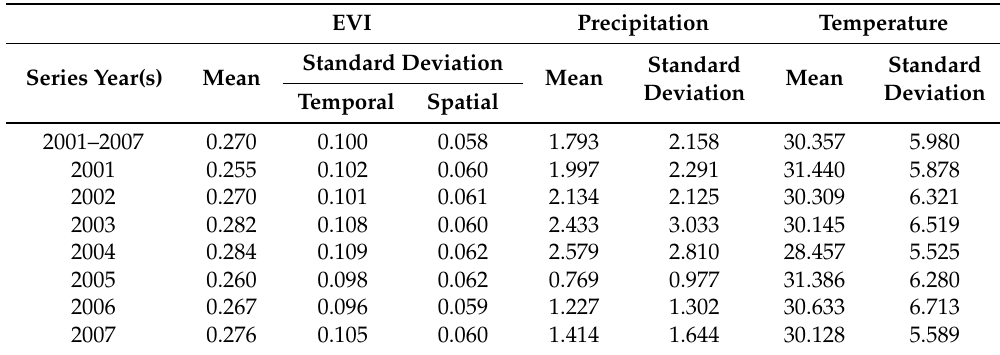
Table 1. Summary statistics of time series of dependent and independent variables across entire Lerma-Chapala-Santiago watershed. Series Year(s) Mean